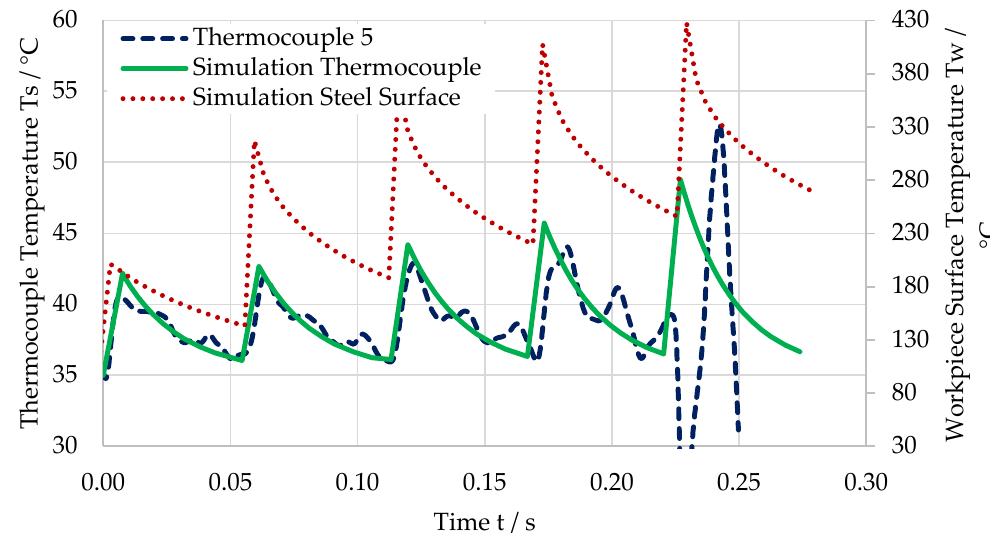
and the calculated temperature of the thermocouple (solid green line) for a feed of f = 36 µm. Again, the measured and simulated temperatures show a very good match, and the workpiece temperature is approximately 10 times higher than the measured temperature. Even the less distinct peak in temperature after the first three cuts can be seen in the meas- urement data.